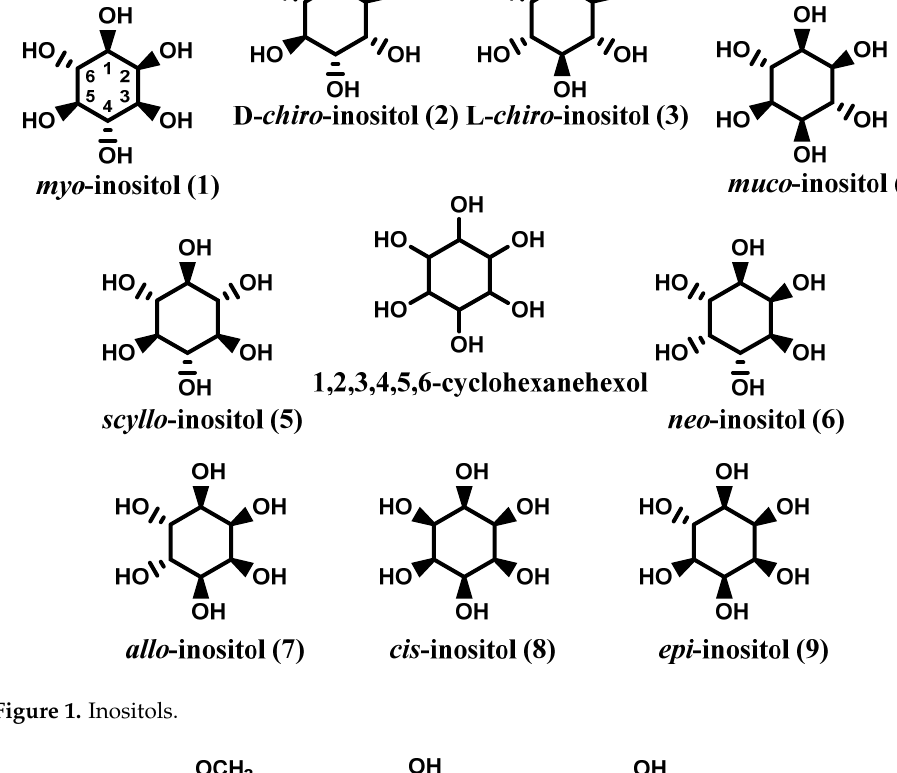
Figure 1. Inositols.